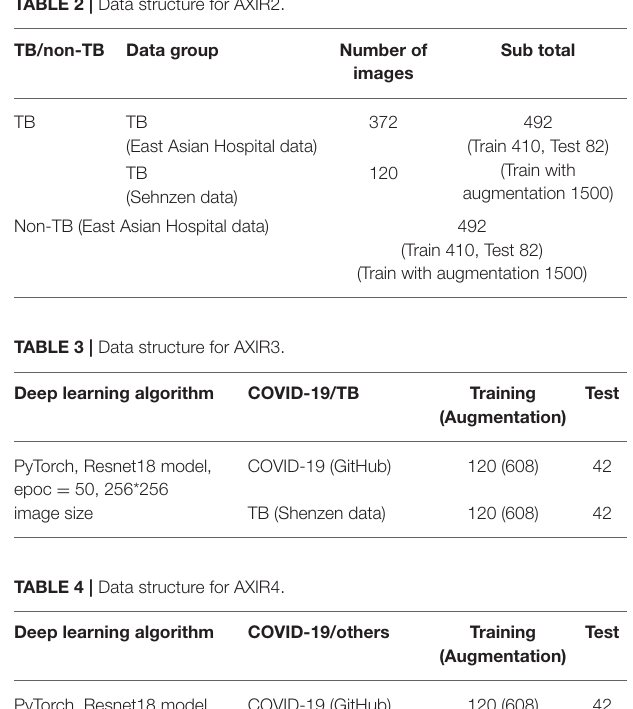
TABLE 5 | Settings for the image augmentation of training